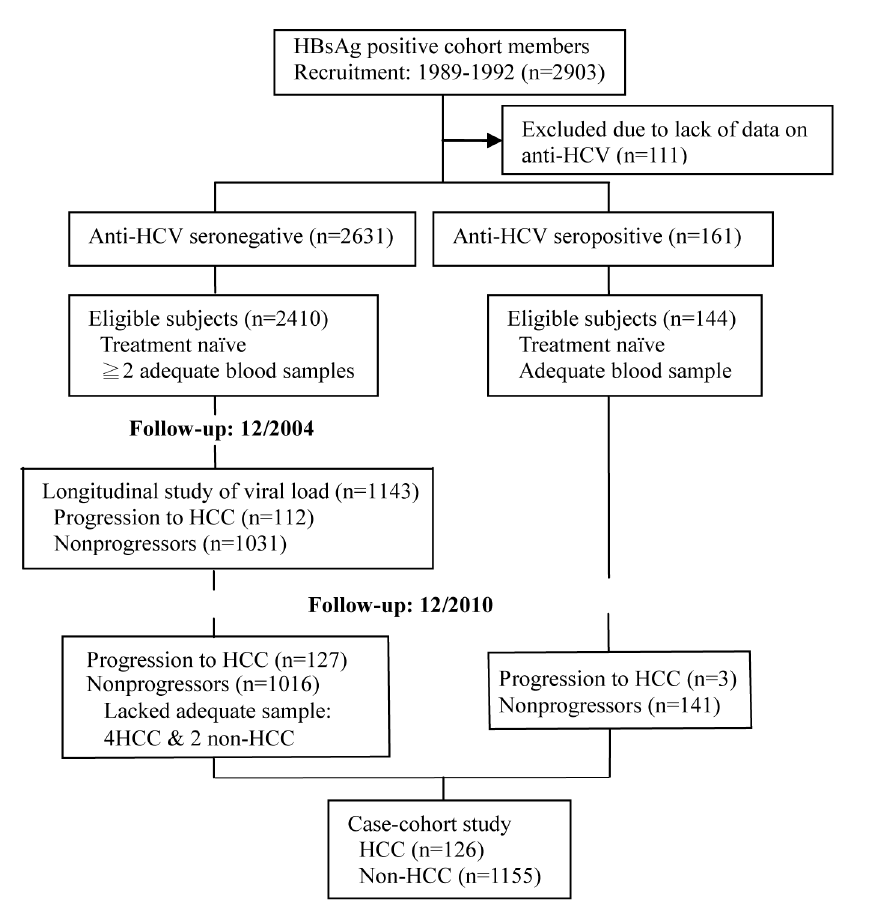
Figure 1. Flow of participant recruitment and follow-up in the case-cohort